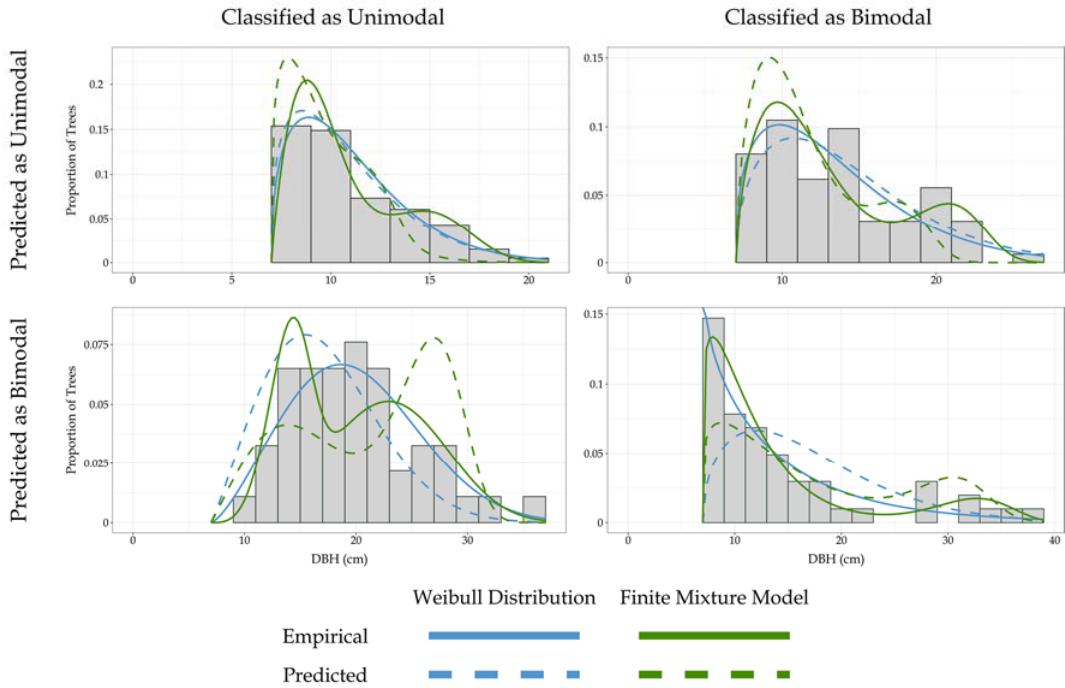
Figure 4. Examples of measured and predicted curves following correct and incorrect differentiation on four plots.